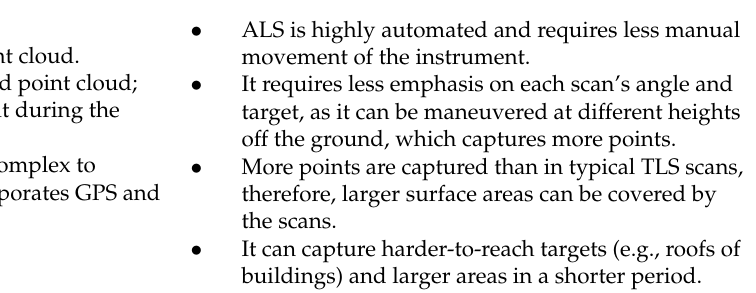
Table 1. Comparison of advantages and disadvantages of TLS and ALS. TLS